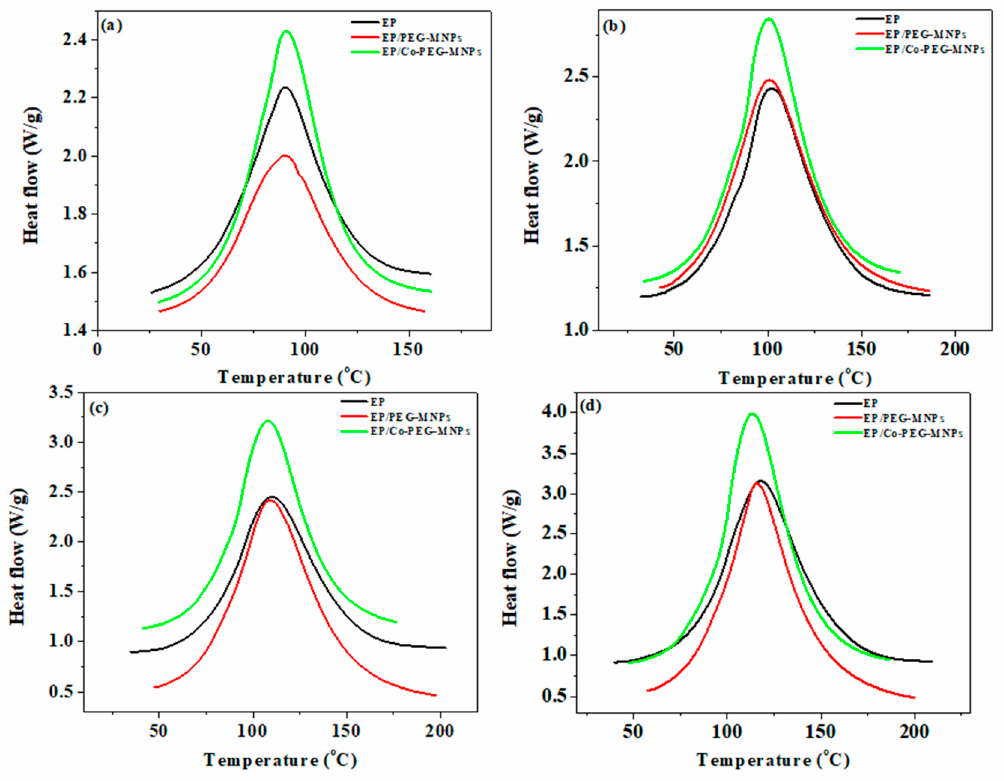
Figure 7. DSC thermograms of EP, EP / PEG-MNPs and EP / PEG-Co-doped MNPs obtained